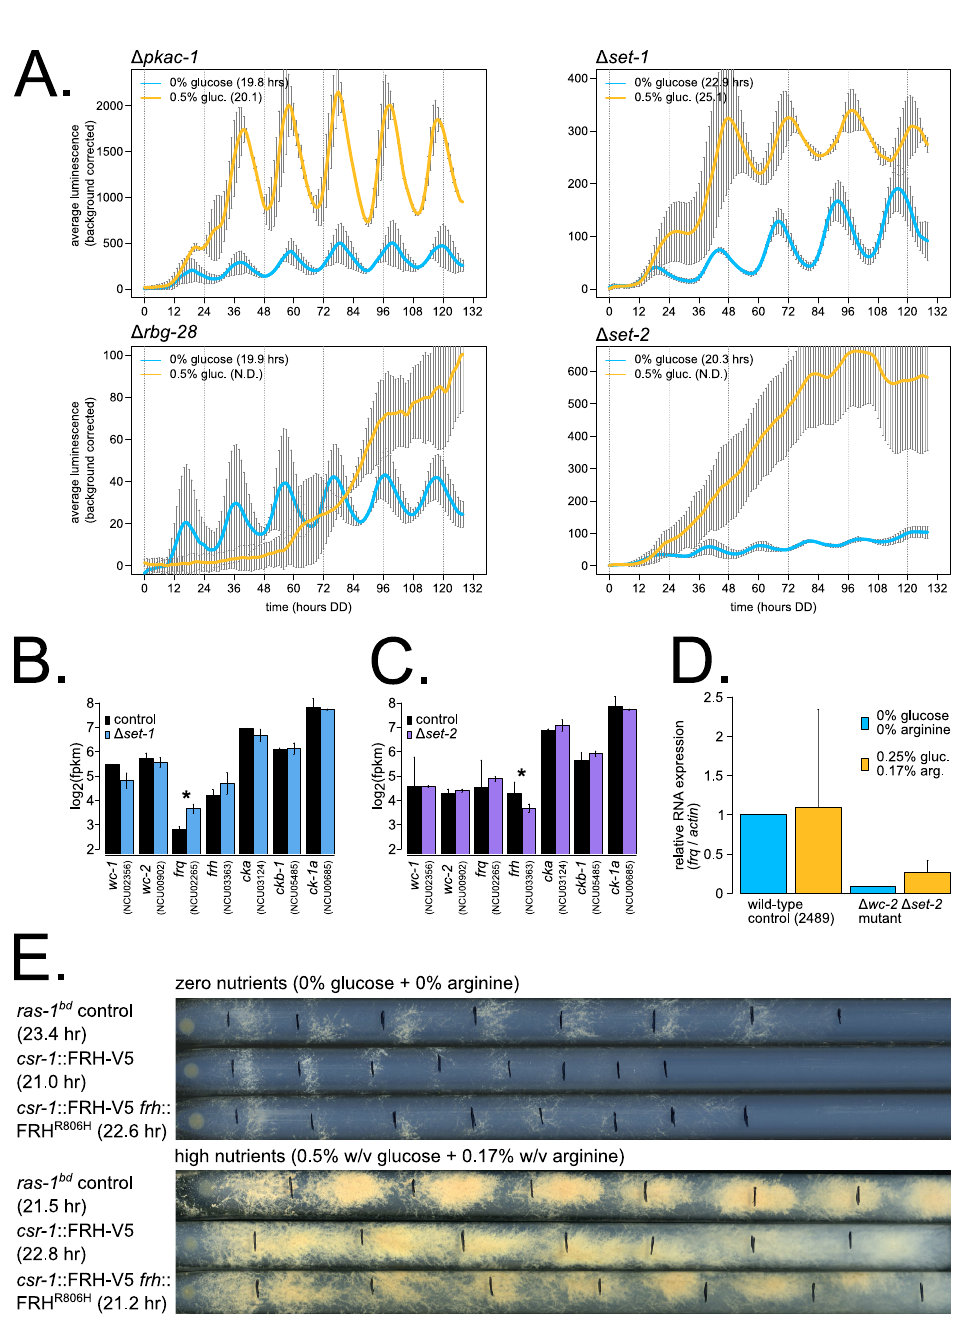
Fig 5. Nutritional over-compensation mutants are enriched for chromatin regulators, implicating frh regulation in Nutritional Compensation mechanism. Circadian bioluminescence was recorded from race tube cultures of the indicated deletion mutants. High nutrient medium (yellow lines) contained 0.5% w/v glucose 0.17% w/v arginine, and zero nutrient medium (blue lines) contained 0% glucose 0% arginine (standard deviation error bars). Period lengths are indicated as insets ( N = 2–4 biological replicates per nutrient concentration) ( A ). RNA-Sequencing data were mined from a previous study [71] (Materials and methods), where 2% (high) glucose liquid cultures were harvested at circadian time point DD24. Log 2 -transformed FPKM values are shown for core clock gene expression levels ( N = 2 biological replicates per genotype). The asterisk indicates p = 0.05 ( � ) by Student t test comparing mutant to control levels. The frq transcript is 1.78-fold more abundant in Δ set-1 ( B ). RNA-Sequencing data were mined from a previous study [73] (Materials and methods), where 1.5% (high) sucrose liquid cultures were sampled. Log 2 -transformed FPKM values are shown for core clock gene expression levels ( N = 2 biological replicates for Δ set-2 , and N = 6 biological replicates for controls). The asterisk indicates p < 0.05 ( � ) by Student t test comparing mutant to control levels. The frh transcript is 1.61-fold less abundant in Δ set-2 ( C ). RNA expression levels were measured from the indicated genotypes